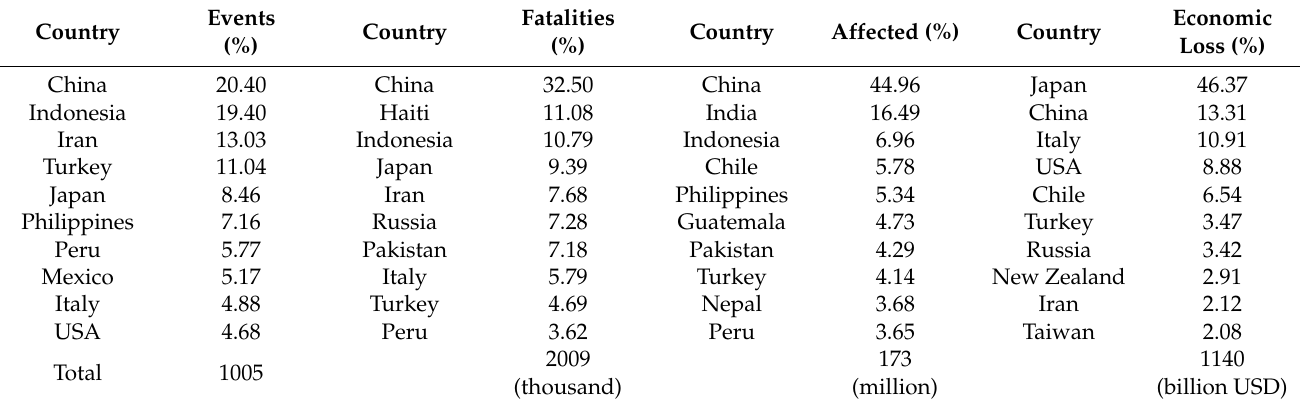
Figure 3. Global hotspots for geophysical disasters based on data for the top 10 countries in each category from 1900 to 2020 AD (Data Source: [57]). Table 1. Distribution of events, fatalities, affected people, and economic loss in top 10 countries due to geophysical disasters from 1900 to 2020 AD (Data Source: